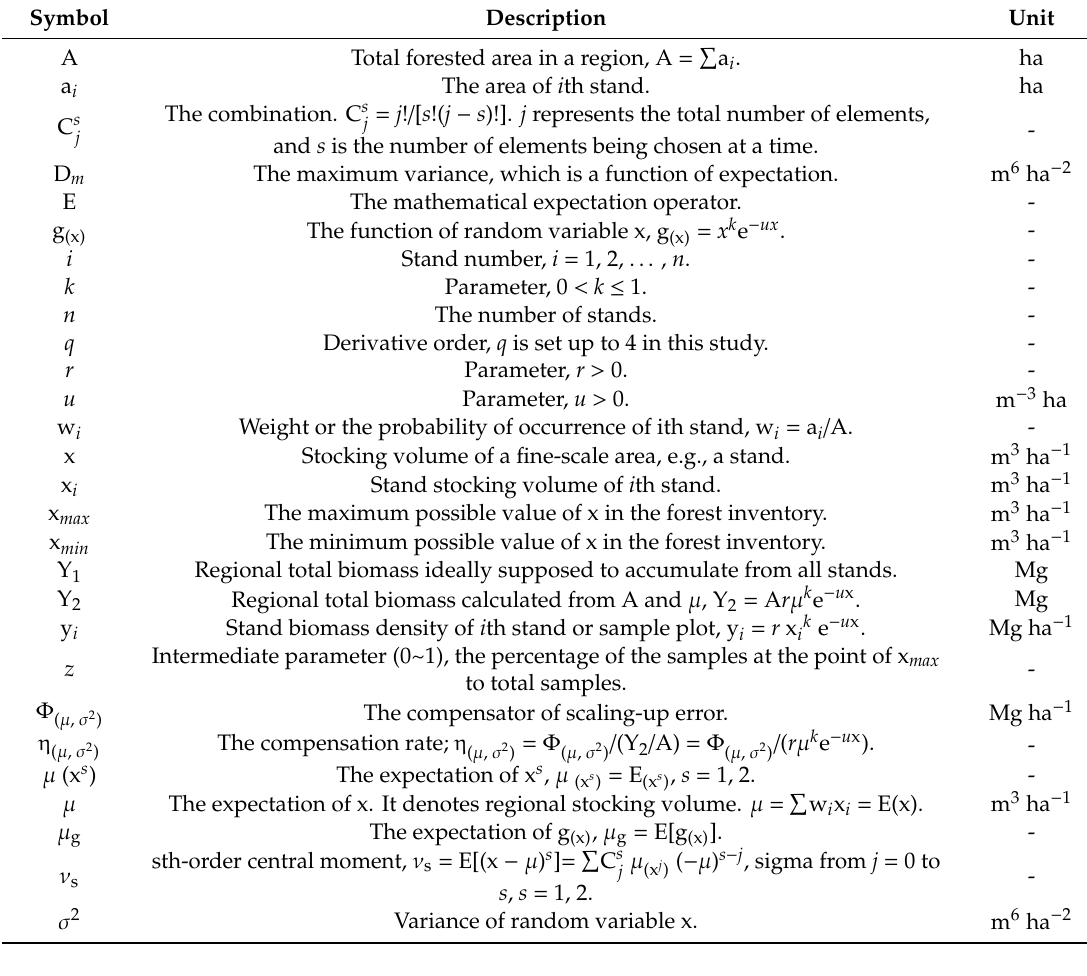
Table 1. Symbols and their